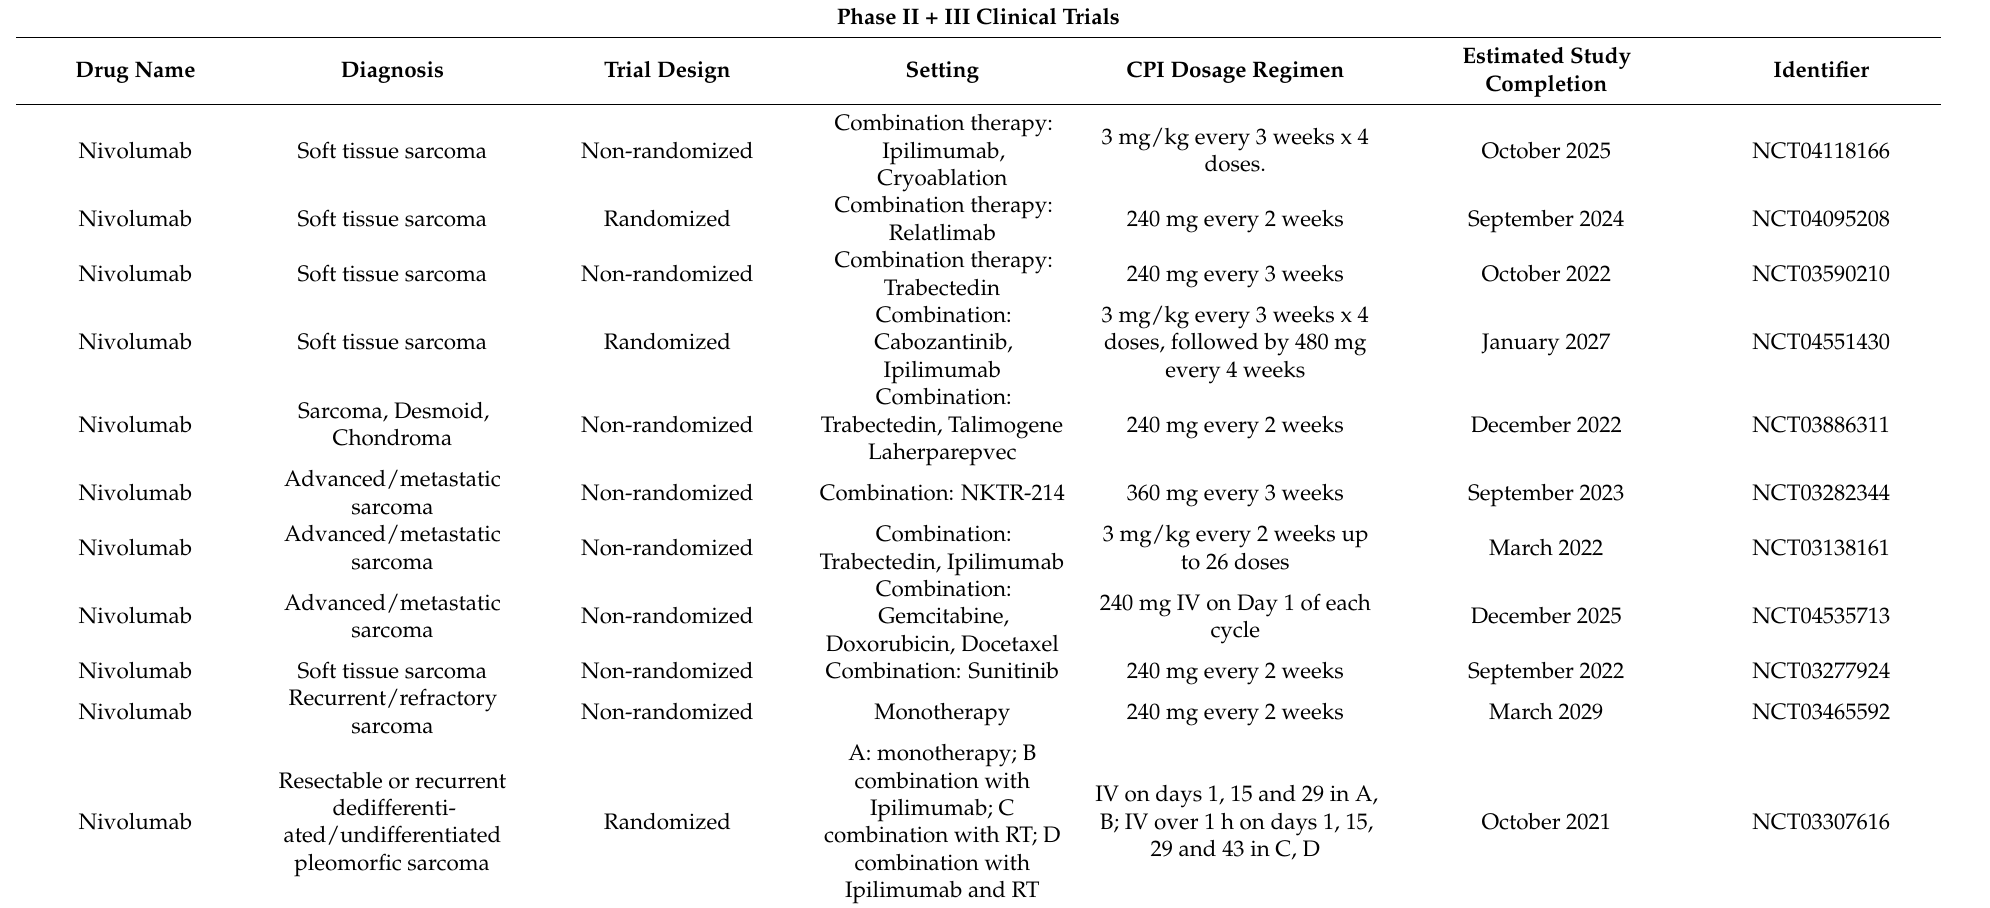
Table 1. A list of phase II and III active or recruiting clinical trials with nivolumab, pembrolizumab, and ipilimumab in soft tissue sarcomas. Excluded were withdrawn clinical trials, completed trials and trials of unknown status. Red triangle indicates phase III clinical